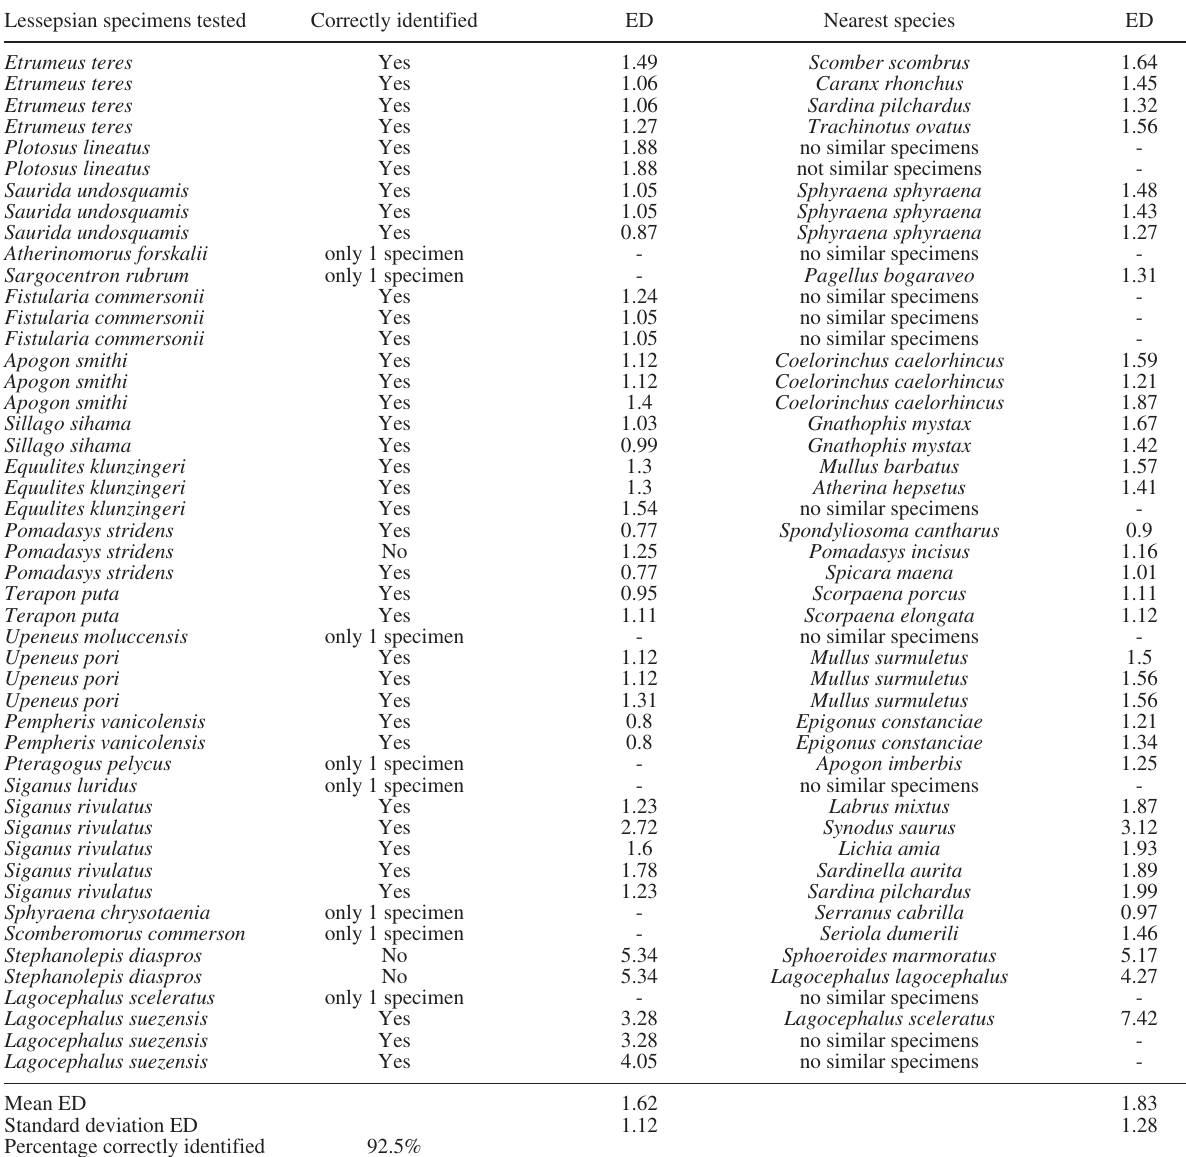
Table 2. − Comparison of the otolith contour of Lessepsian species with other species from the Mediterranean Sea using the automatic system analysis of AFORO web. ED, Euclidean Distance. Lessepsian specimens